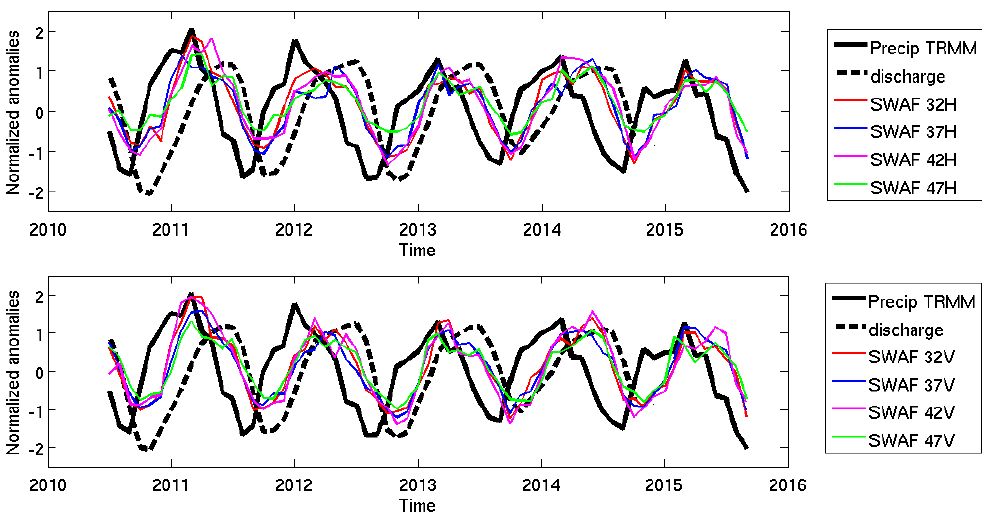
Figure 13. Monthly normalized anomalies of precipitation (TRMM data), in situ discharge at Obidos and the SWAF at H-pol (top) and V-pol (bottom) with the four incidence angles considered in this study. The precipitation and SWAF anomalies were computed over the entire Amazon